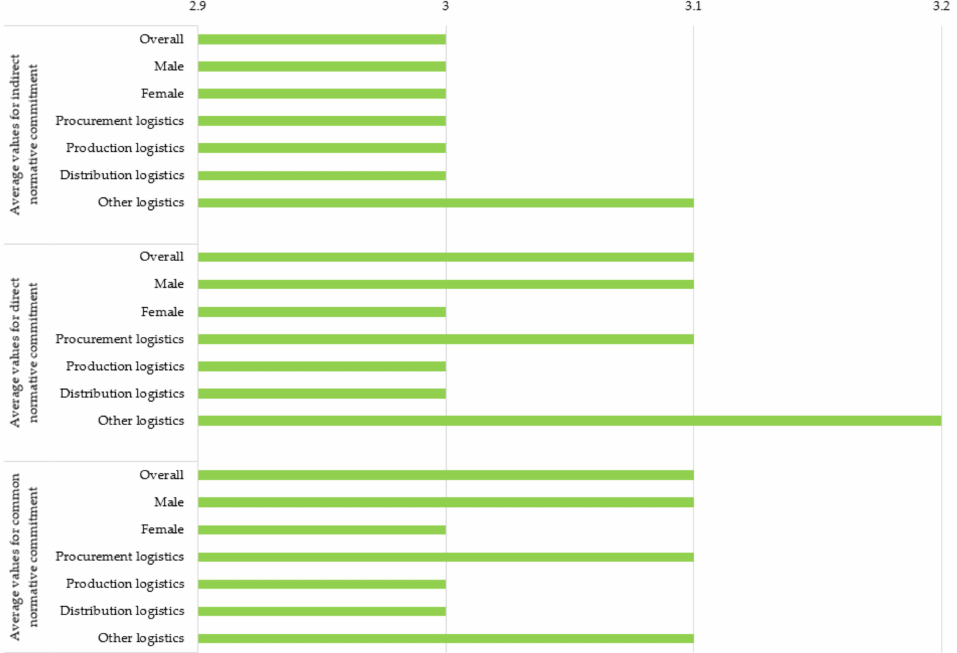
Figure 5. Current status of NC in sample enterprises (1 means a very low value, 5 means a very high